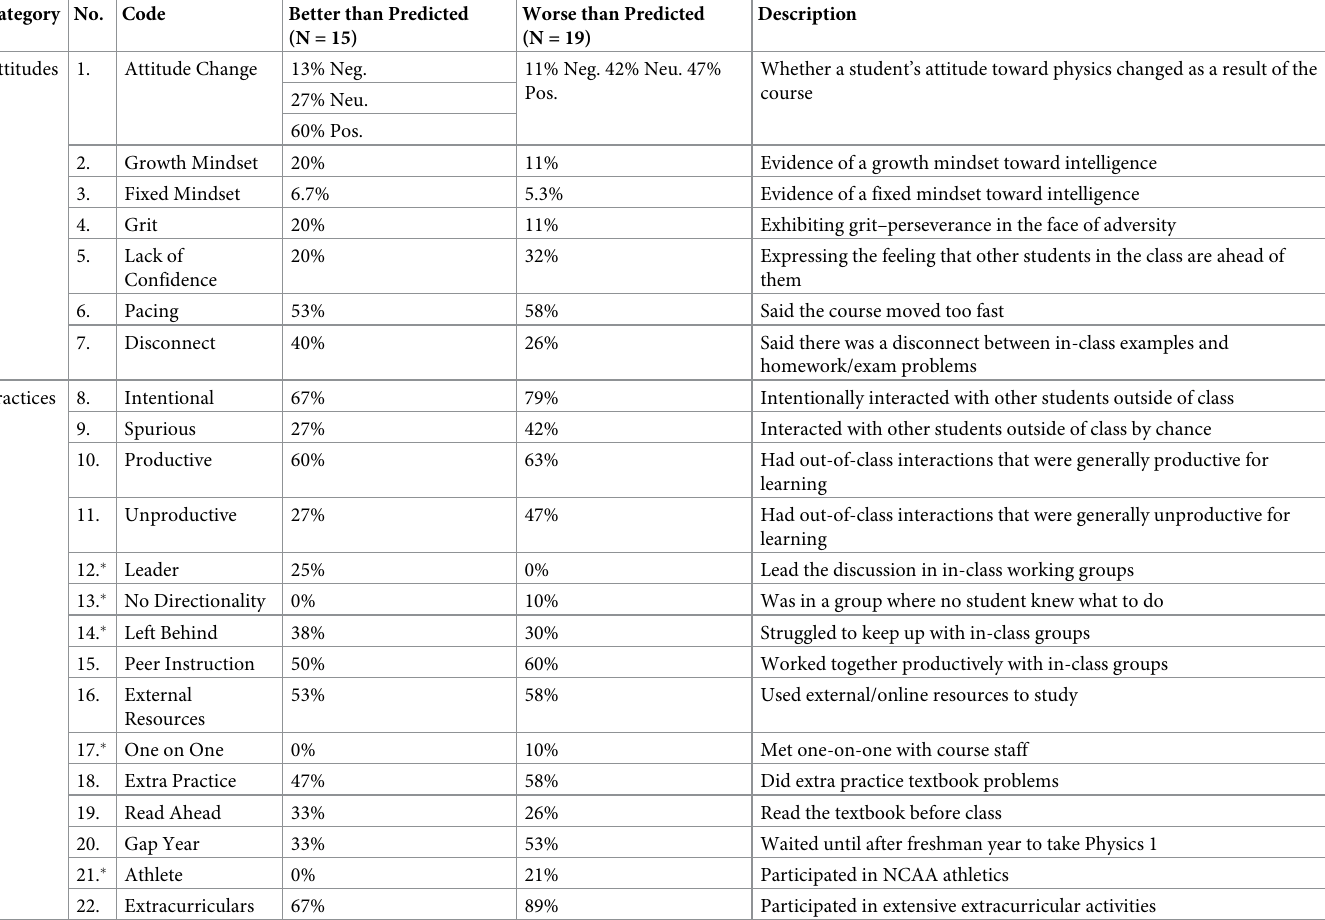
Table 3. List of issues that arose from qualitative analysis of student interviews. Percentages shown are the fraction of the students in the respective course perfor- mance category that listed that attitude or practice. Note that the in-class interactions 12–15 are based only on the students who were in the companion course (N = 17); the remaining issues are based on the entire sample. The � indicates a practice mentioned by a very small number of students and we caution the reader that inference is quite limited. Category No.